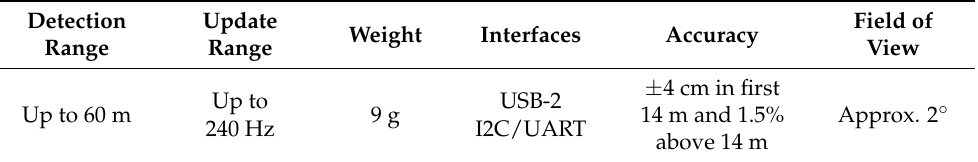
Table 2. Specification of Evo 60 m Time of Flight (ToF) sensor [26].